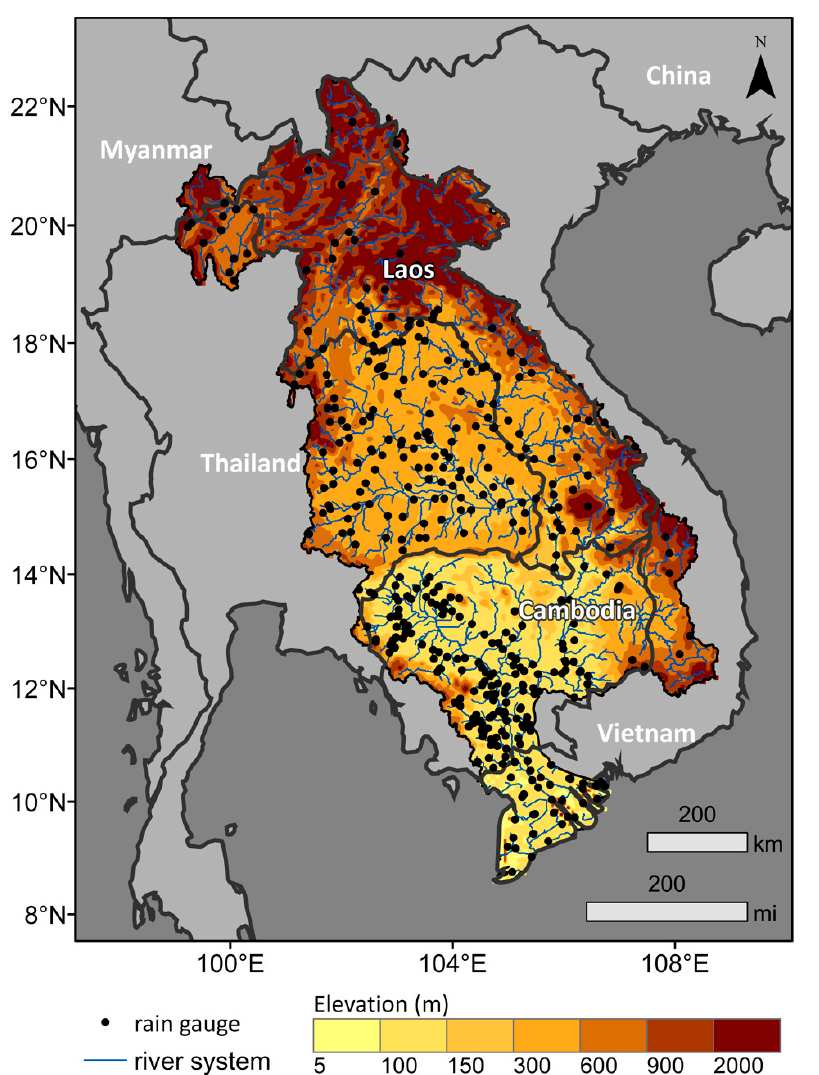
Figure 1. Map of the Lower Mekong River Basin in Southeast Asia and the locations of the rain gauge stations within the basin.